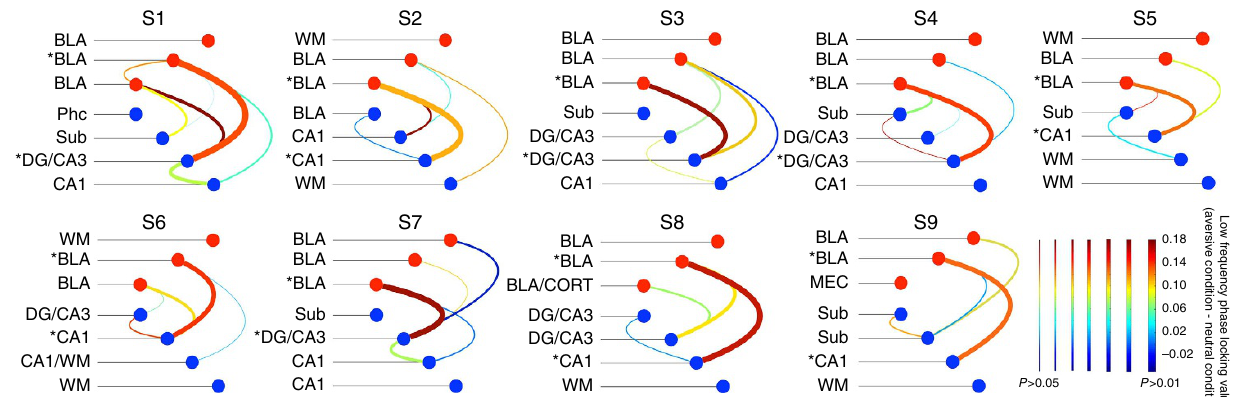
Figure 2 | Differences in amygdala-hippocampal low-frequency phase coupling. Low-frequency phase coupling differences (aversive—landscapes) for pairs of electrodes targeting the amygdala (red dots) and hippocampal subfields (blue dots), depicted with hive plots. Differences in the PLV between aversive and neutral conditions are presented in colour, with warmer colours indicating a greater magnitude of the contrast. Significance levels derived from permutation testing are indicated by the thickness of lines connecting each electrode pair. Asterisks represent electrode pairs with the most significant PLV that were used for directional coupling analyses in Figs 3 and